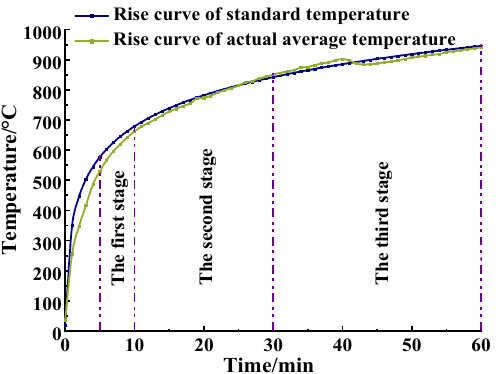
Figure 7. Time curve of standard/actual average temperature in the furnace.